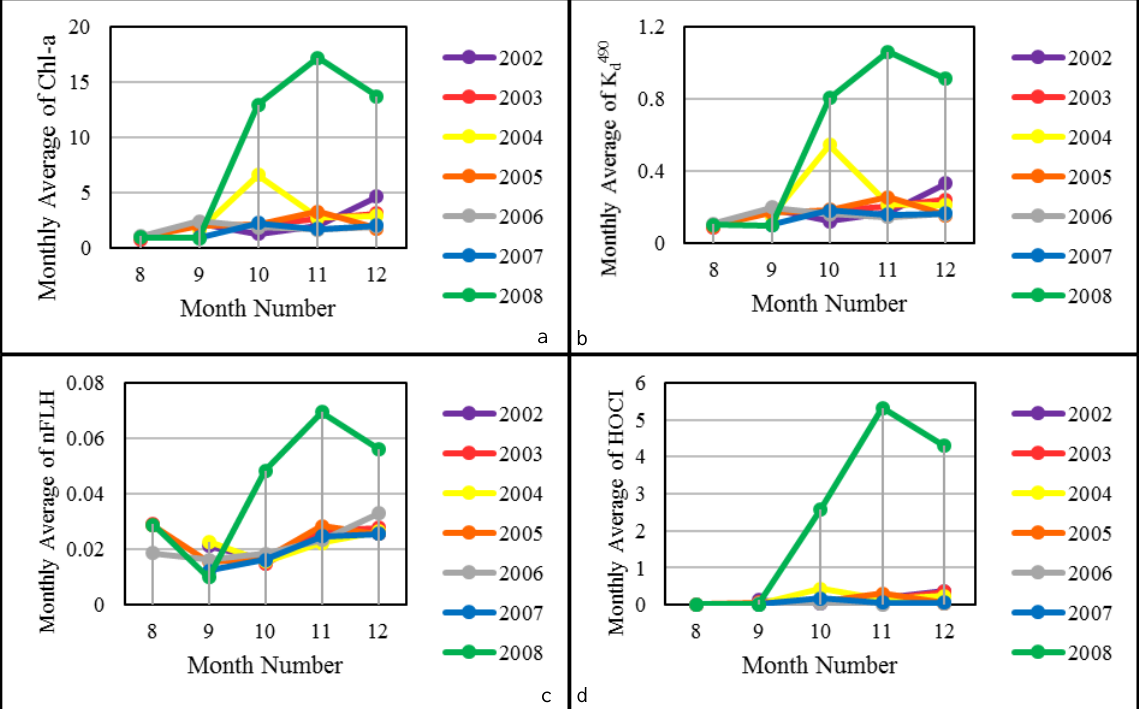
Figure 3. Monthly variations of Chl-a, K d490 , nFLH, and HOCI between 2002 and 2008. Longitude range: 56°20’28”- 56°34’24”, latitude range: 26°22’51”- 27°04’36”.